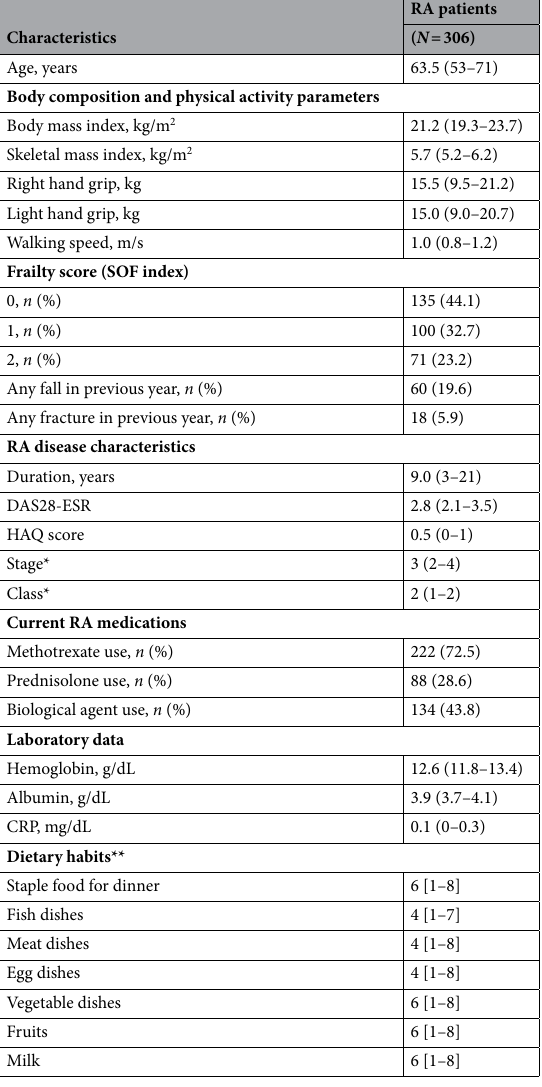
arthritis, SOF index Study of Osteoporotic Fractures index, DAS28-ESR 28-joint Disease Activity Score using erythrocyte sedimentation rate, HAQ health assessment questionnaire, TNF tumor necrosis factor,